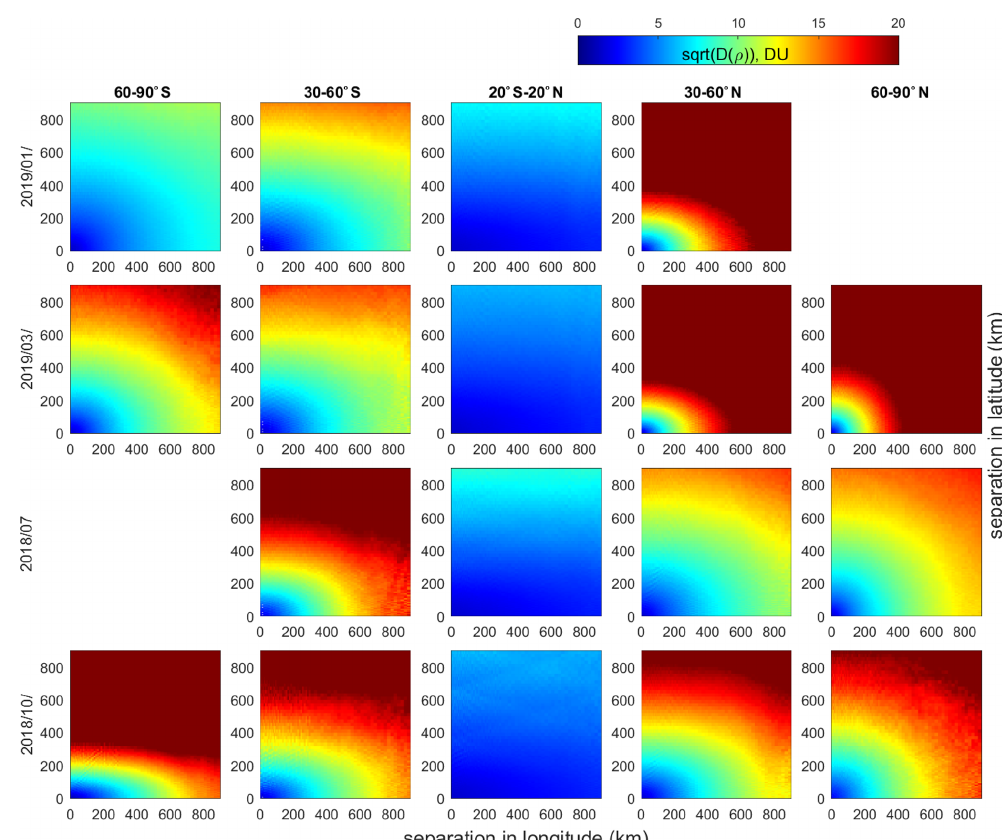
√ D( ρ ) in DU) for different latitude bands (columns) and months (rows).